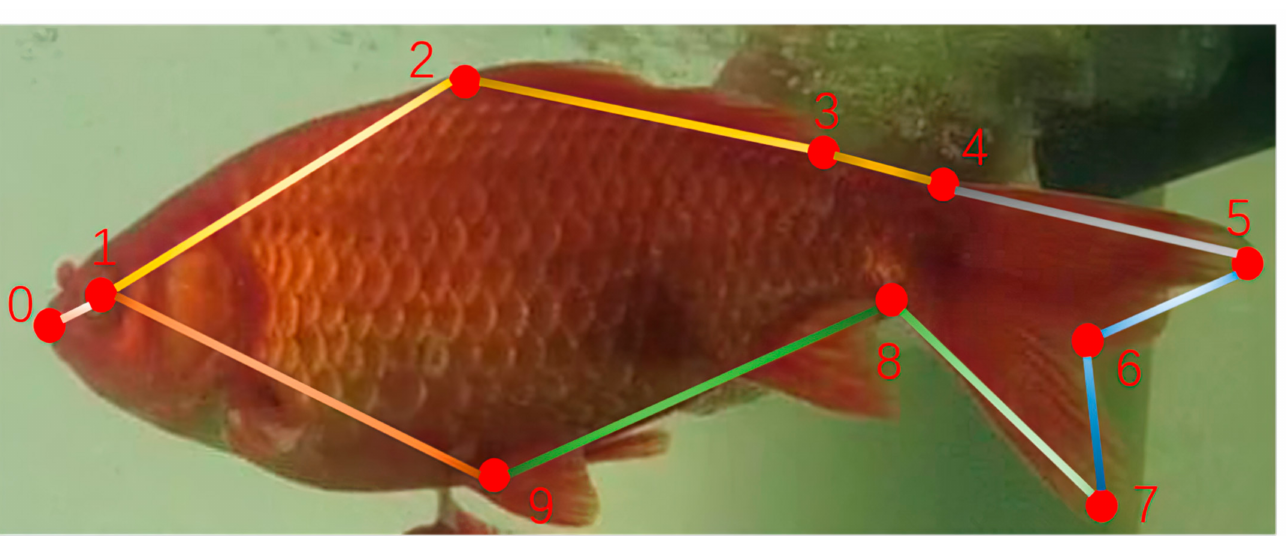
Figure 3. Definition of key points of crucian carp (0–9).